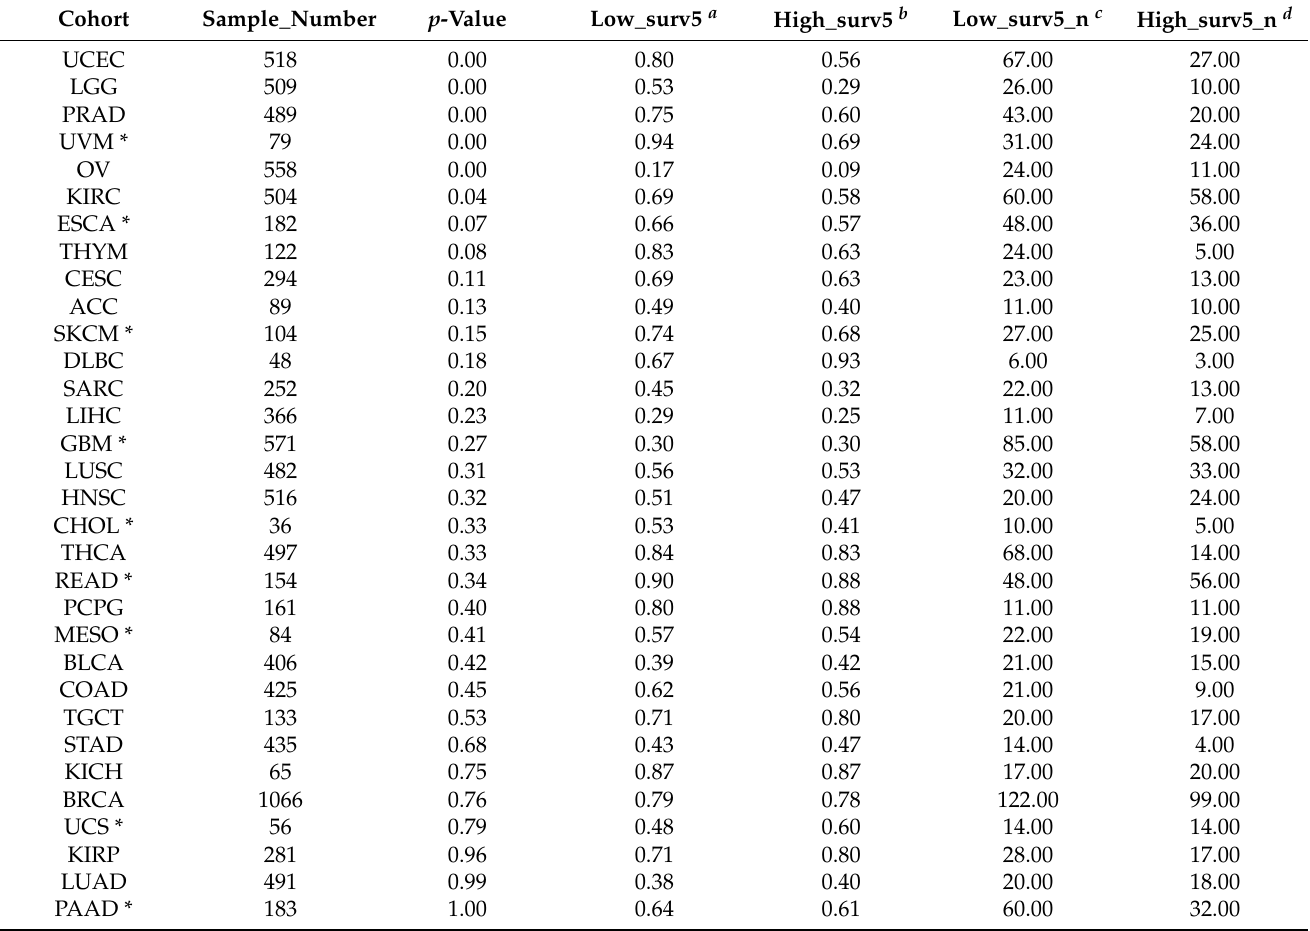
Table A5. Association between W-CIN and progression-free survival across cancer types.